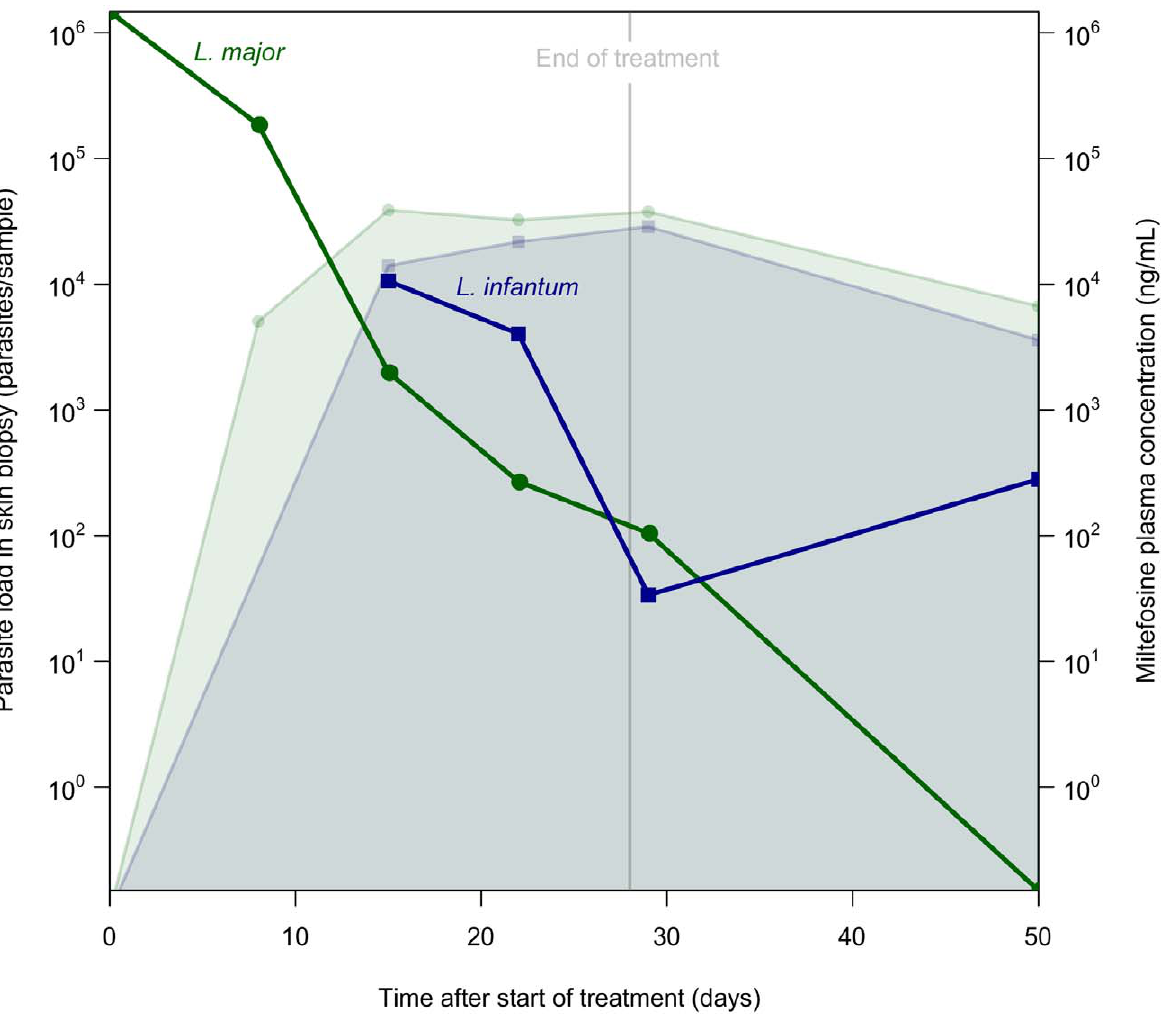
Figure 2. Leishmania parasite loads in skin biopsies from lesions of two CL patients treated with oral miltefosine. Miltefosine was given (50 mg thrice daily) for a total of 28 days. Miltefosine trough plasma concentrations (ng/mL) are indicated by the colored filled areas. The Leishmania qRT-PCR values of the skin biopsies (parasites/sample) are indicated by colored lines and dots. The green line, circles and filled area represent Patient 1 ( L. major ), while the blue line, squares and filled area represent Patient 2 ( L. infantum ).